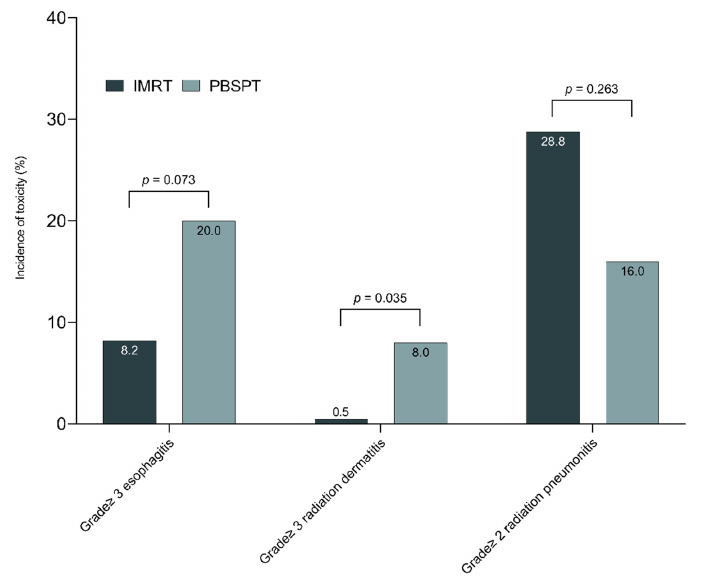
Figure 3. The incidence of specific treatment-related toxicities in patients treated with IMRT and PBSPT. Abbreviations: IMRT, intensity-modulated radiation therapy; PBSPT, pencil beam scanning proton therapy. Table 4. Prognostic factors for grade ≥ 3 acute esophagitis and grade ≥ 2 radiation pneumonitis.